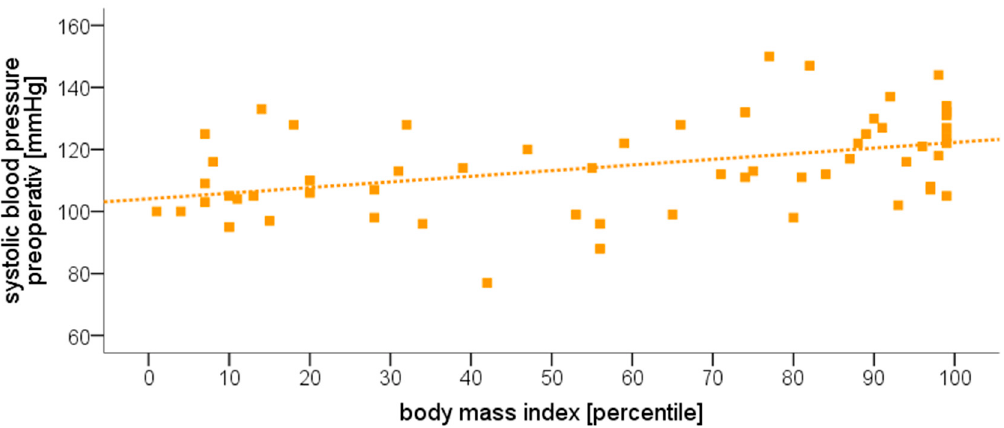
Figure 2. Correlation between body mass index and preoperative systolic blood pressure for all patients ( n = 59; Spearman’s correlation: ρ = 0.452, p < 0.001). The squares stand for individual patients, the dotted line symbolizes the